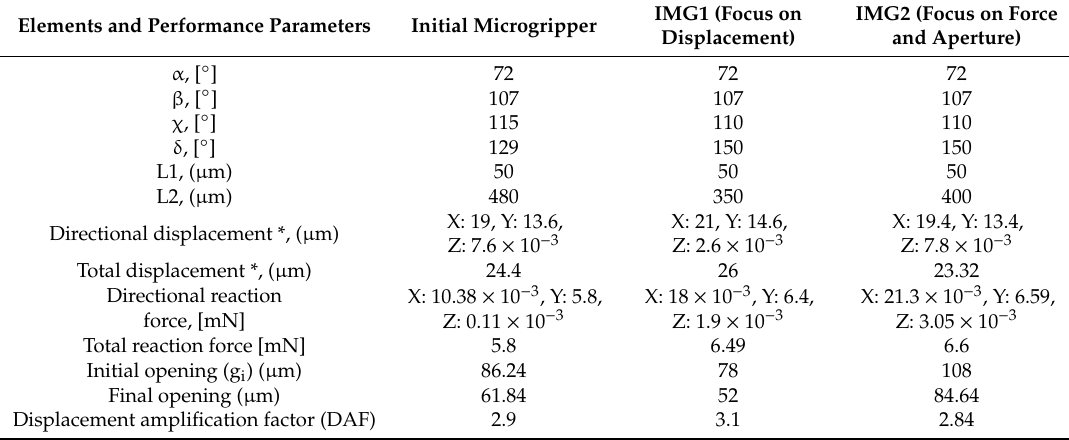
Figure 10. Structure thickness vs. reaction force. Table 6. Values of determinant elements and parameters of the silicon initial and improved microgrippers @ 5 V, with